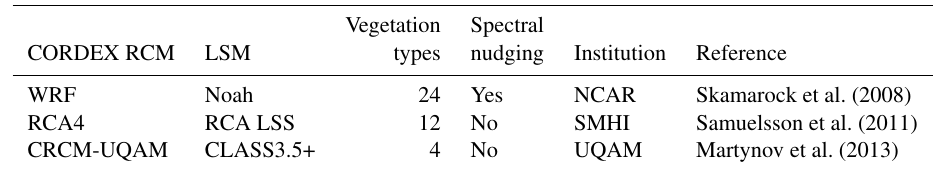
Table 3. Characteristics of the evaluation simulations employed in this analysis from three RCMs participating in the NA-CORDEX project. The boundary conditions for these three simulations are from the ERA-Interim reanalysis. LSS is a land-surface scheme and SMHI is the Swedish Meteorological and Hydrological